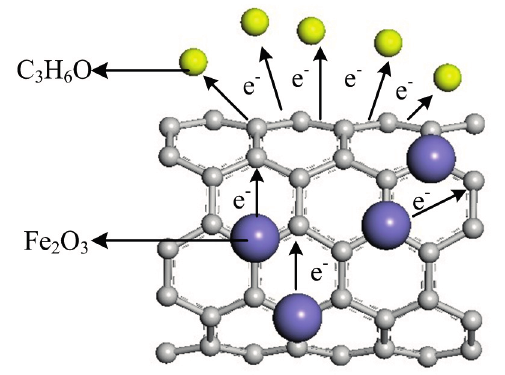
Figure 9. Schematic of the electronic